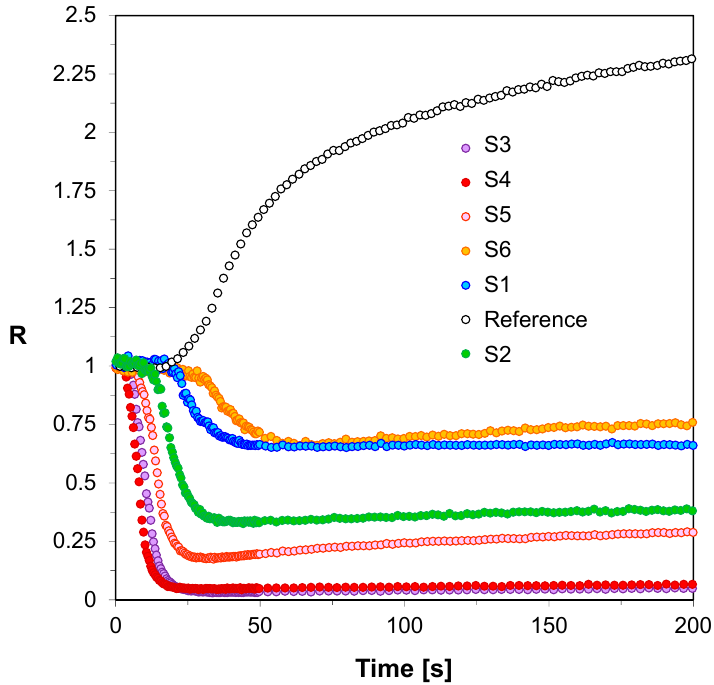
Figure 5. Monitoring cationic photopolymerization of TEGDVE monomer under 320 nm by FPT, using the 2-amino-4,6-diphenyl-pyridine-3-carbonitrile derivatives (S1–S6) as the fluorescent sensors and 25ST as a reference probe.